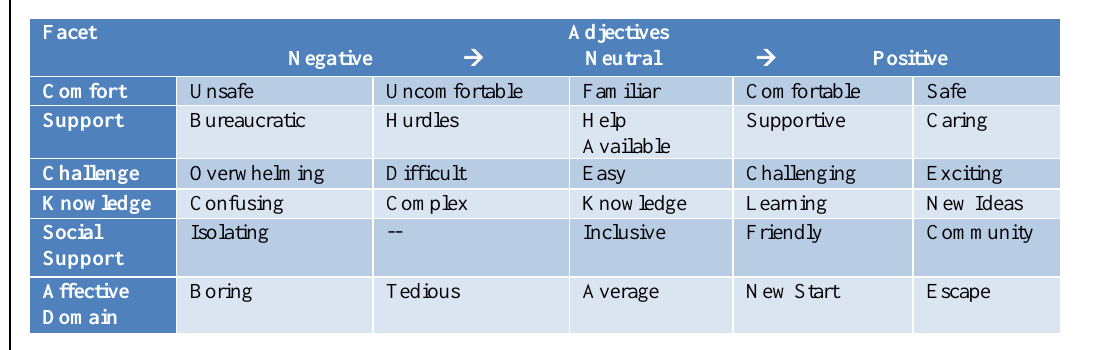
Table 1: Adjectives provided to students in the survey to describe their experiences at university after four weeks of study